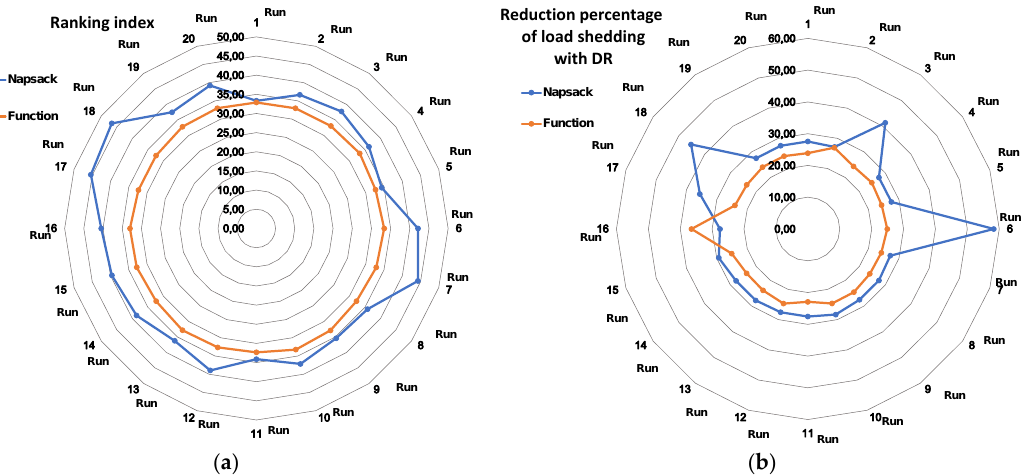
Figure 11. Analysis of performance for 20 runs: ( a ) ranking index; ( b ) reduction percentage of load shedding.